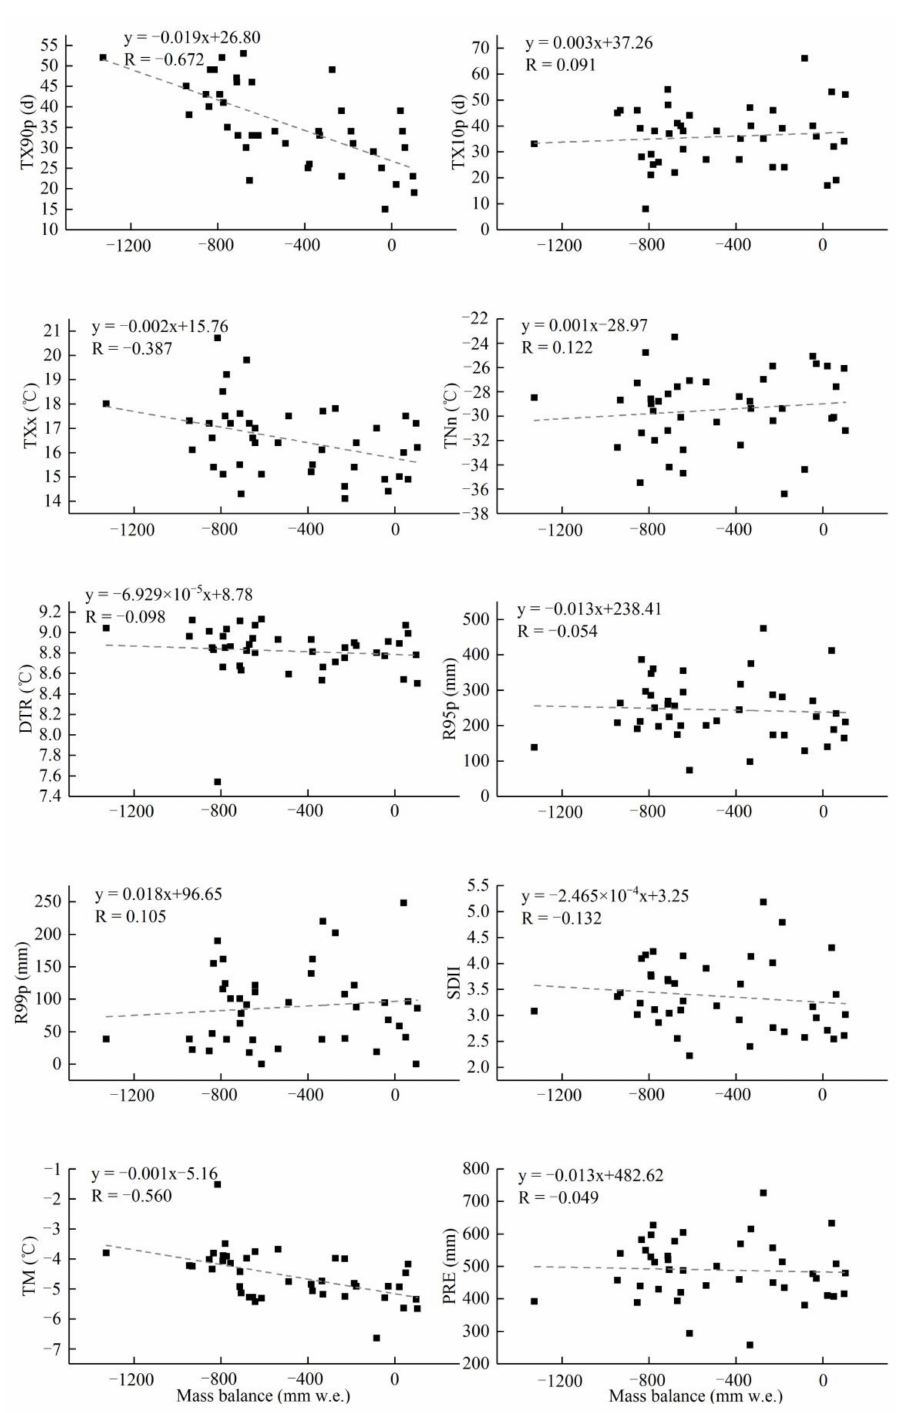
Figure 5. Correlation between annual mass balance and regional mean extreme climate indices of Urumqi Glacier No.1 during periods 1980–2020. The solid lines denote linear